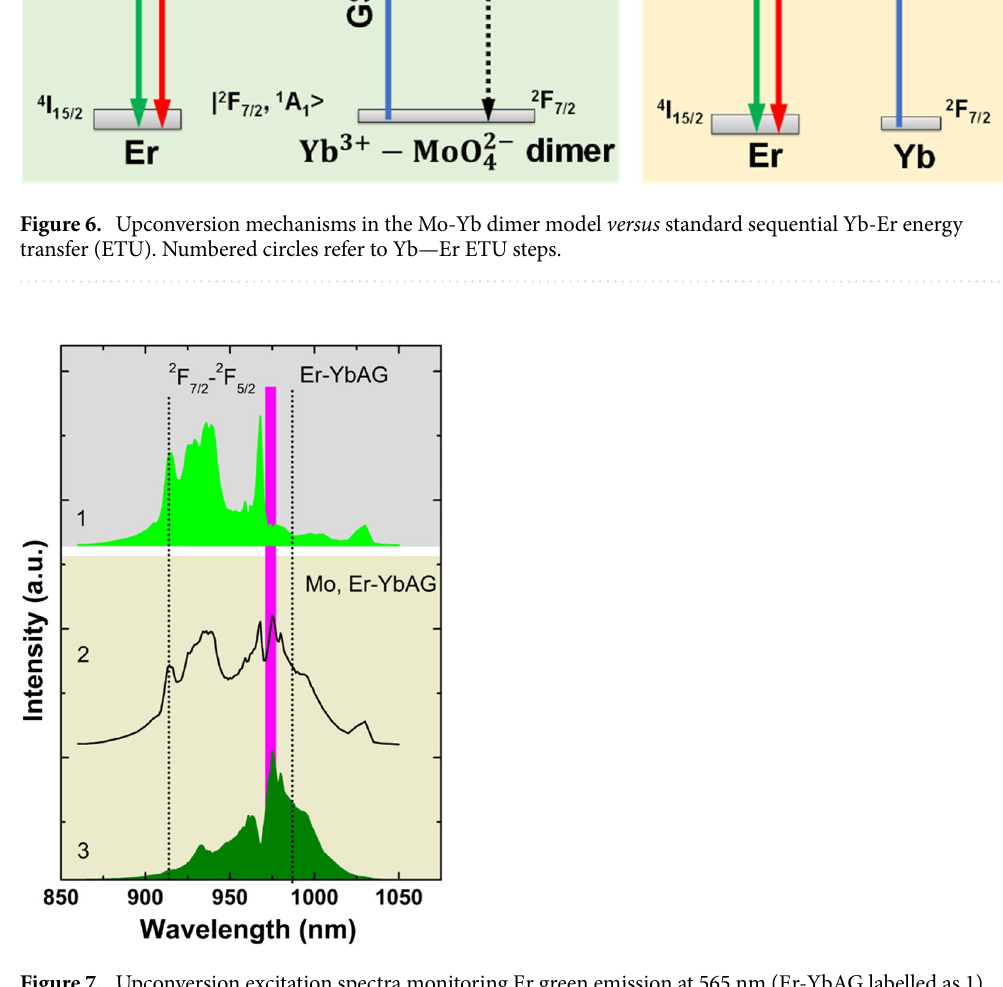
Figure 7. Upconversion excitation spectra monitoring Er green emission at 565 nm (Er-YbAG labelled as 1), 515–575 (Mo, Er-YbAG labelled as 2) and 530 nm (Mo, Er-YbAG labelled as 3); The magenta and black vertical lines correspond to the excitation wavelengths used in cw and pulsed laser excitation, respectively. The laser energy density is 20 mJ/cm 2 . All spectra are normalized at the maximum